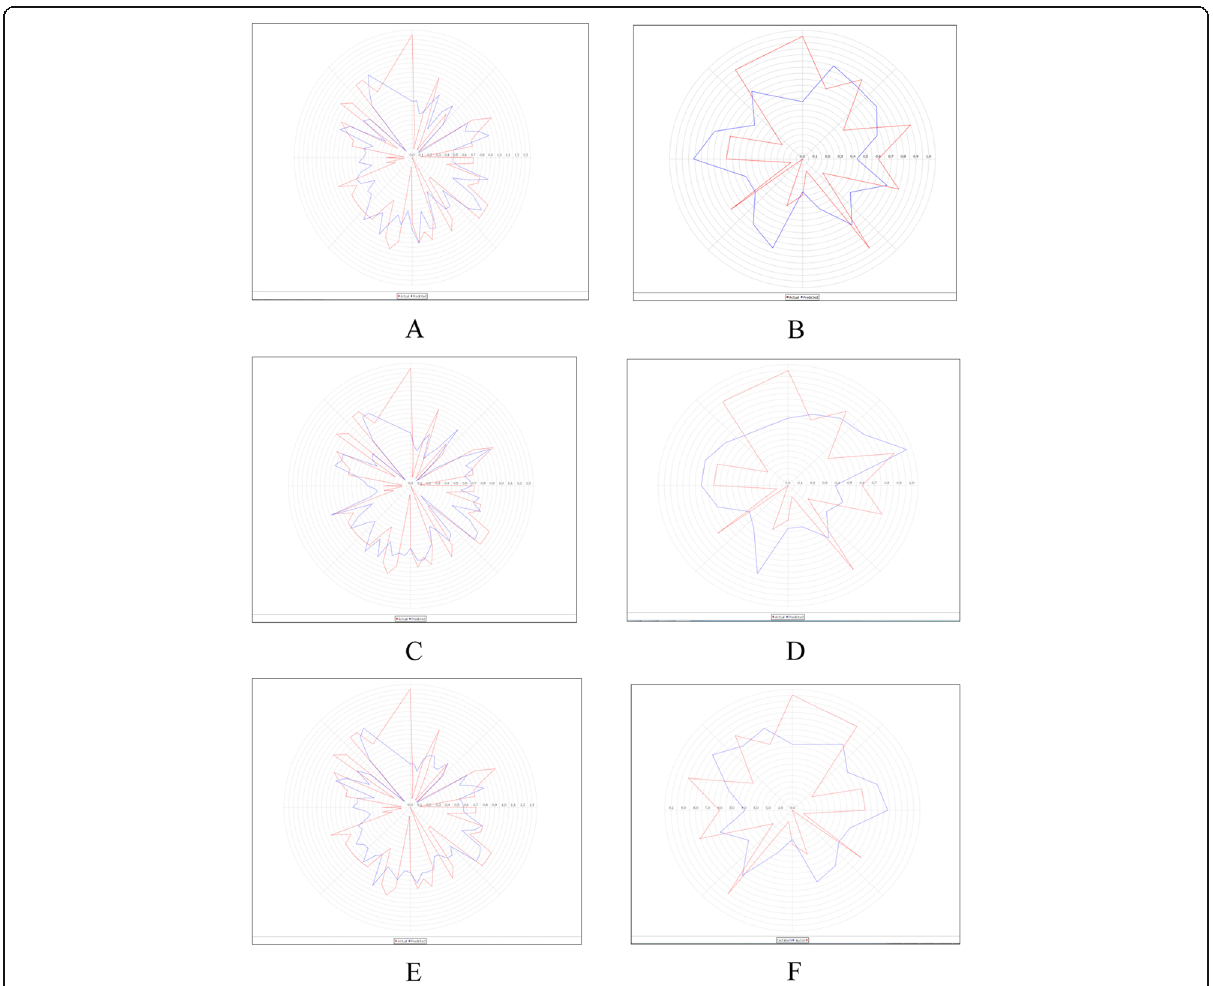
Fig. 5 a – f Actual vs predicted activity of training and test set compounds for model-I, model-II, and